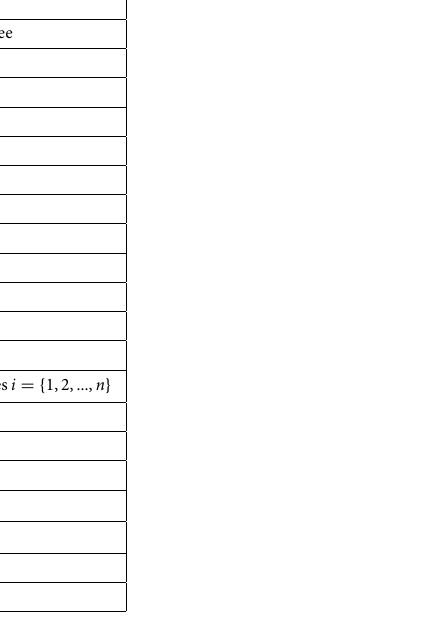
Table 1. Definitions of